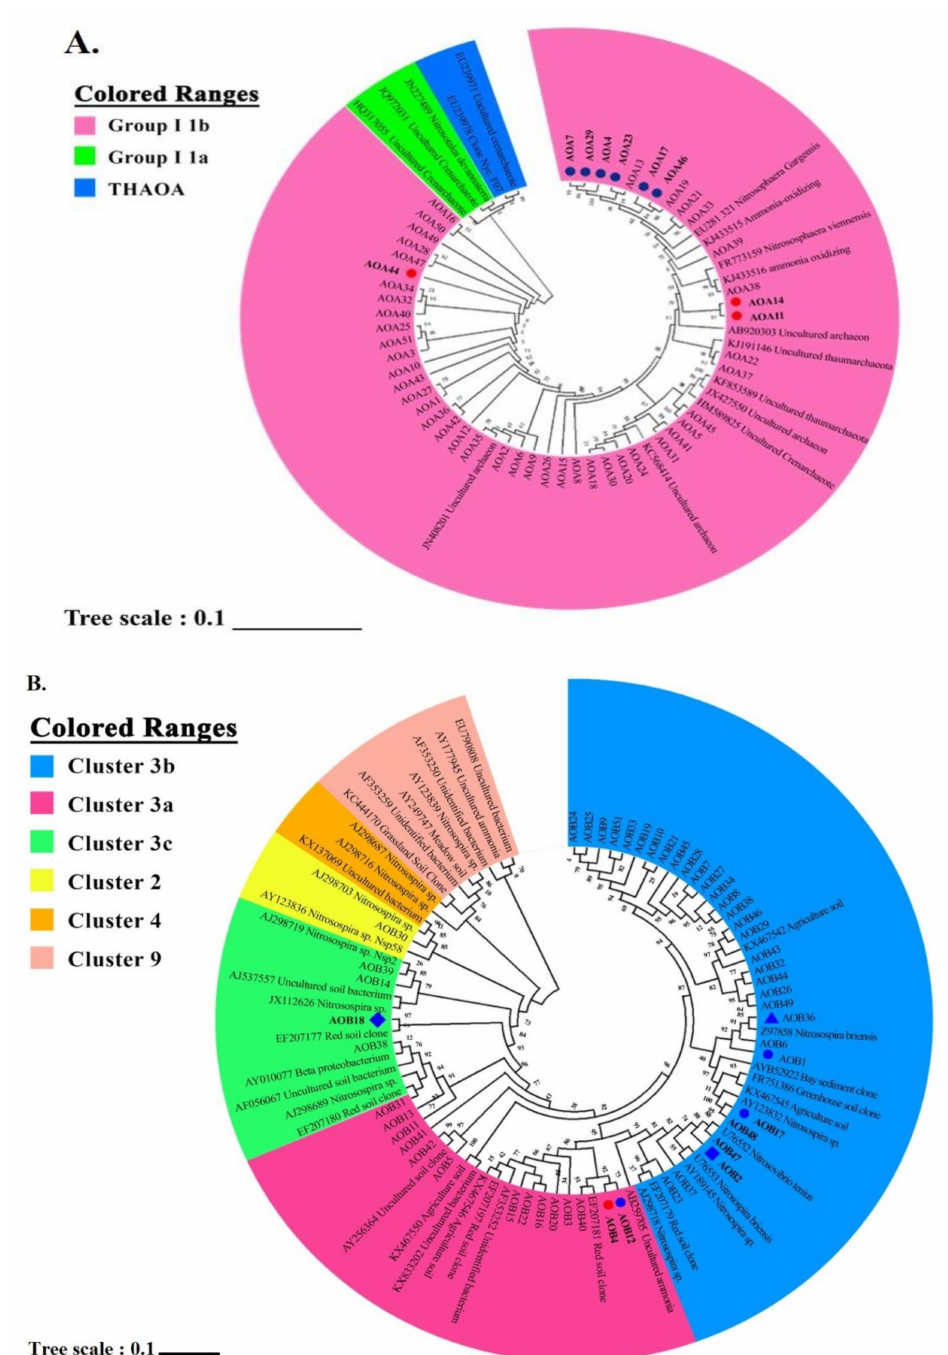
Figure 5. Neighbor-joining tree of ( A ) amoA AOA and ( B ) AOB amoA genes of the 50 most abundant samples and their nearest neighbors in the custom FunGene amoA sequence database. The NCBI taxonomic classification of the database entries is included. The percentage of clone trees in which the related taxa clustered together in the bootstrap test (1000 replicates) are shown next to the branches (bootstrap value > 50 percent). The significant difference between inorganic amendment (CF) and control (NA) is represented by circle and triangle represents a significant difference between cow manure plus inorganic amendment (SC) than control (NA), the rectangle represents a significant difference between maize stove amendment (MS) than control (NA), and a diamond represents a significant difference between cow manure only (MS) than control (NA). The color blue indicates a significantly higher abundance than the control amendment, while the color red indicates a significantly lower abundance than the